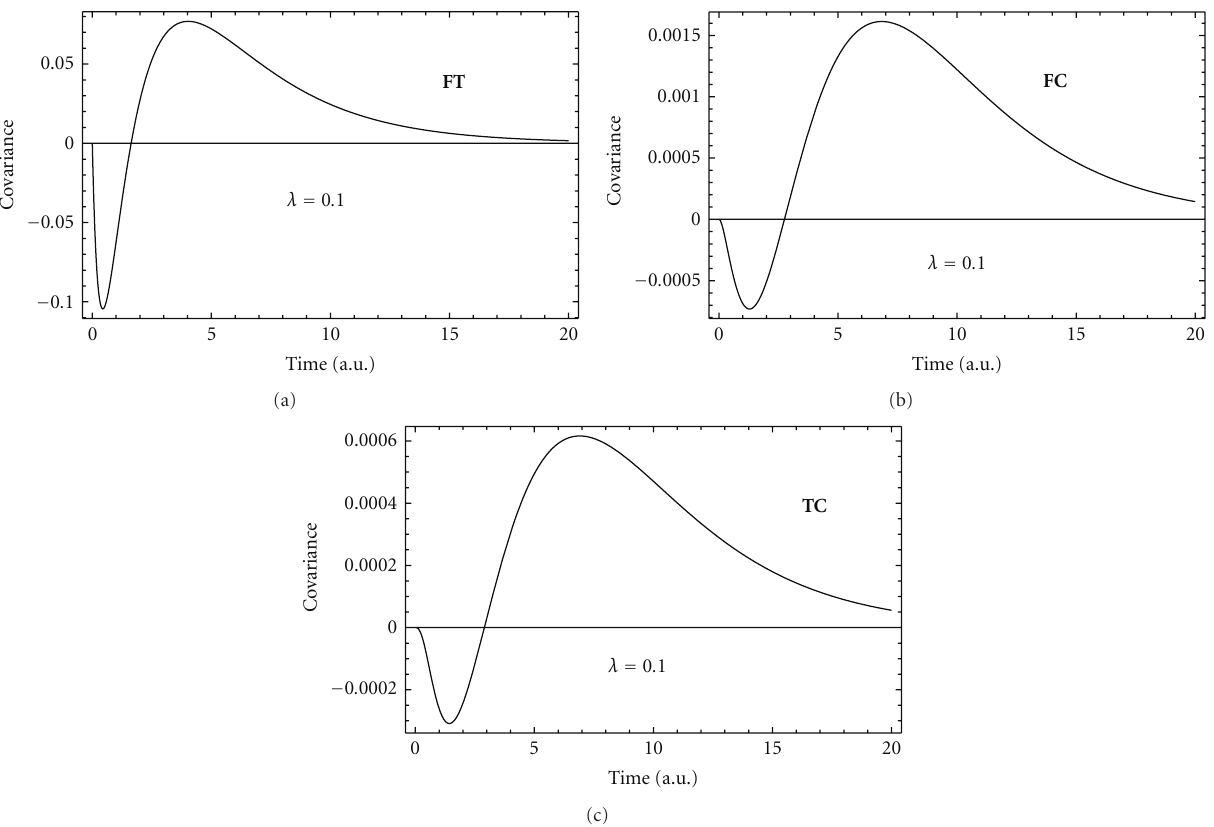
Figure 4: Dependence of the covariances between the numbers of particles of types F and T , as well as F and C , and also between the numbers of particles of types T and C on the time, assuming that the starting particle was F